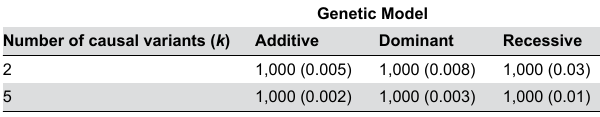
Table 2. Number of cases/controls ( n ) and effect size ( δ ) of any causal allele used at each simulation setting under the two and five non-interacting causal variant scenario of Experiment